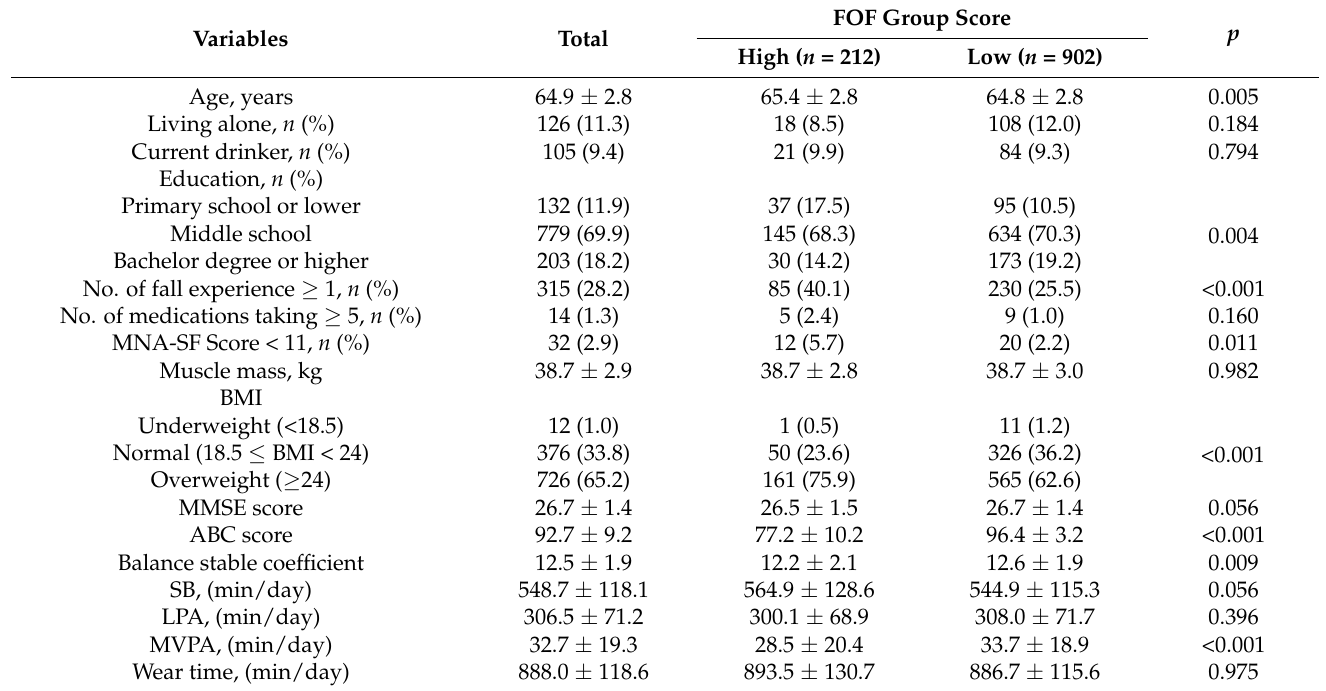
Table 1. Characteristics of participants by FOF classification ( n = 1114; collected from March to June 2020 in Yantai,